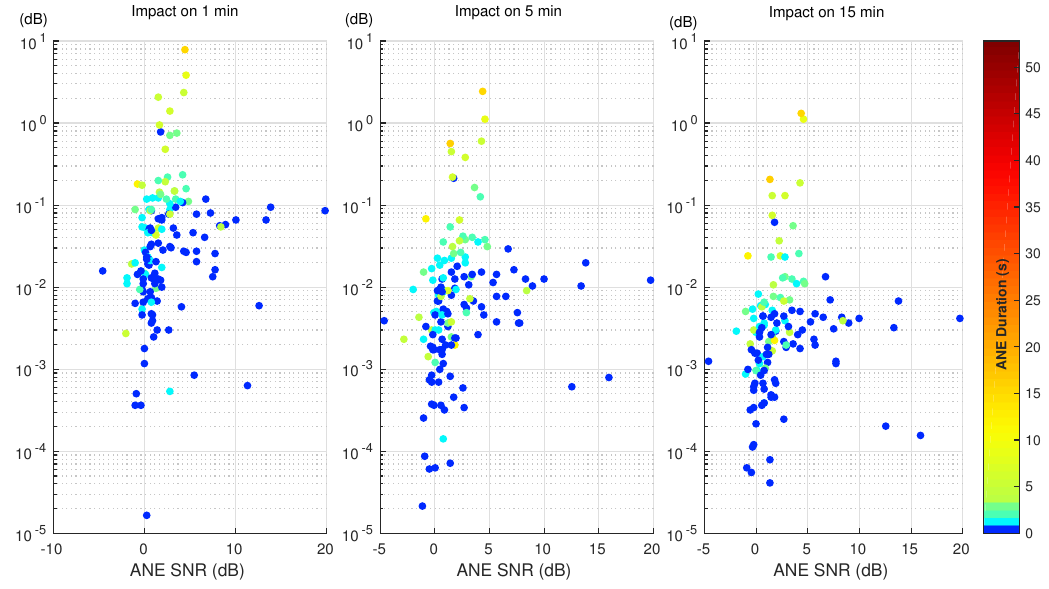
Figure 3. Impact of individual ANEs on the L Aeq value for the 1, 5 and 15 min integration times in the suburban scenario.